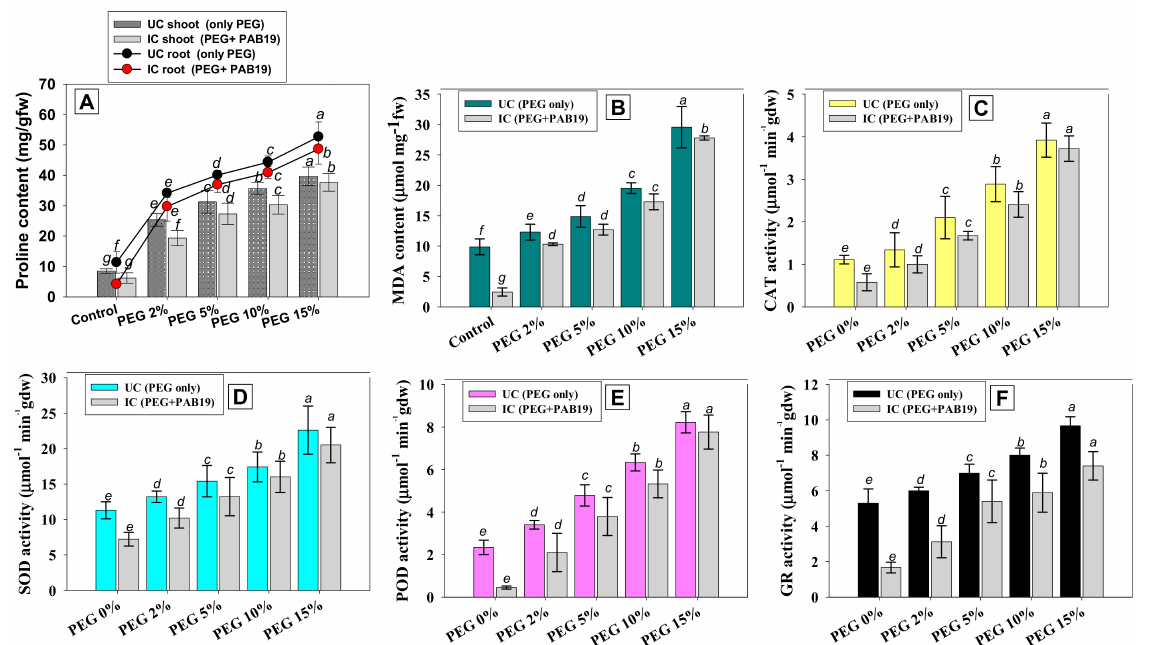
Figure 7. Impact of drought-tolerant Enterobacter sp./ L. adecarboxylata PAB19 on stress-related parameters; proline ( A ) and MDA ( B ) contents and antioxidant enzyme activities; CAT ( C ), SOD ( D ), POD ( E ), and GR ( F ) of V. radiata cultivated in the presence of different levels of water stress (2%, 5%, 10% and 15% PEG-6000) raised under greenhouse conditions. Bar diagrams represent the mean values of three replicates. Mean values followed by different letters are significantly different ( p ≤ 0.05) as determined by the DMRT. Bar and scatter plots represent means ±